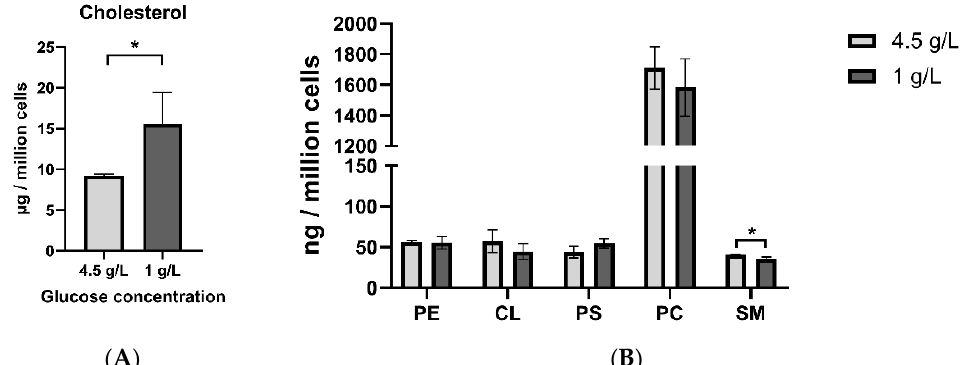
Figure 1. Cellular cholesterol (µg/million cells) ( A ) and phospholipid (ng/million cells) quantities ( B ) in HT22 neurons. * p < 0.05 ( n = 3–6); data are expressed as mean + SD. CL—cardiolipin; PC— phosphatidylcholine; SM—